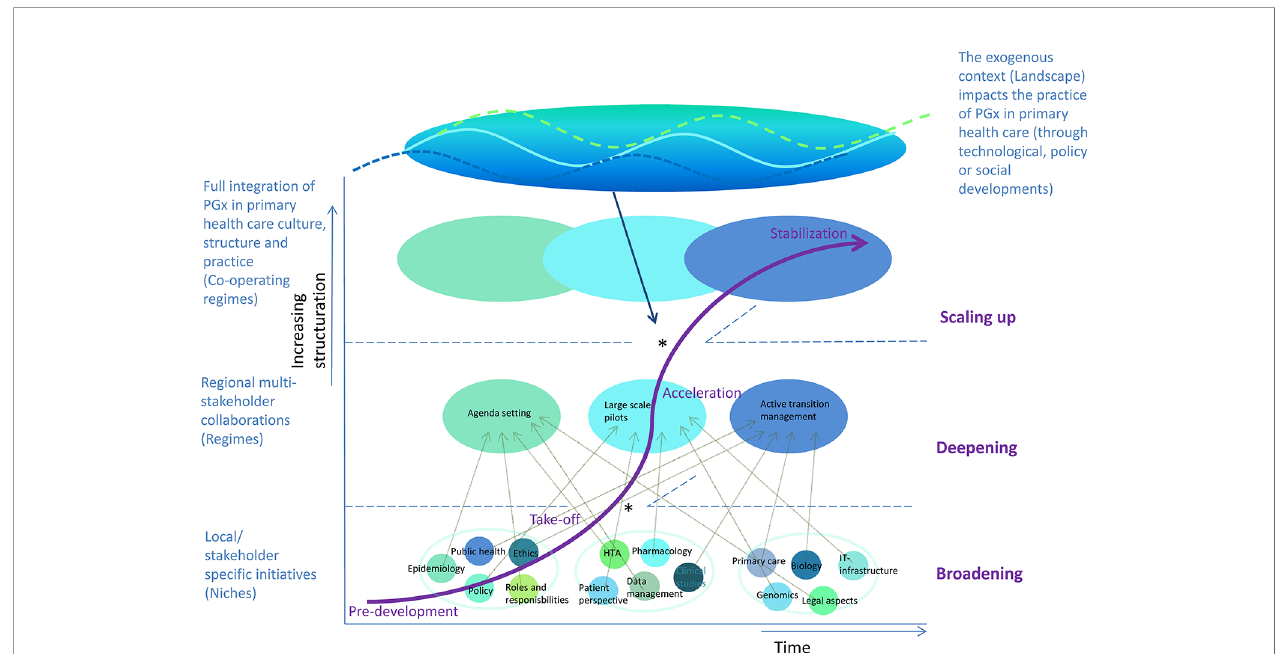
FIGURE 4 | True integration of pharmacogenomics in primary health care requires different transitions [adapted from (Rotmans et al., 2001; Geels and Schot, 2002; Geels, 2007)]. Local or stakeholder-speci fi c initiatives will need to transform to a patchwork of multi-stakeholder collaborations which could create pressure to sustainably change the existing health care culture, structure, and practice. This could be achieved by joint efforts to 1) broaden implementation: transitioning from the pre-development to take-off phase of transitions requires effective learning processes on multiple dimensions; 2) deepening implementation: transitioning from the take-off phase to acceleration of transitions requires attunement and collaboration between stakeholders to align (lessons) from earlier niche applications; and 3) scaling-up implementation: transitioning from the acceleration to stabilization phase of transitions requires true changes in thinking, organizing, and doing of stakeholders. Furthermore, taking advantage of windows of opportunities (*) to next phases in transition (often achieved by alignment of different initiatives and/or stakeholders) could facilitate structuration and thereby integration of new ways of thinking, doing, and